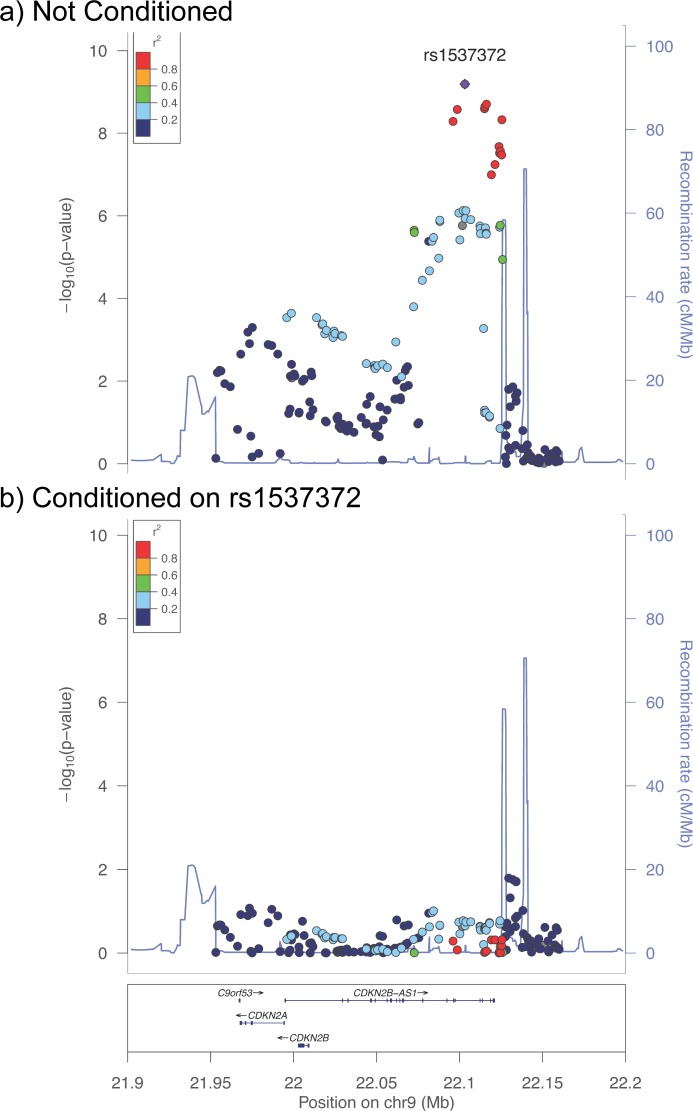
Conditional Analysis of the 9p21 Region.“Locus Zoom” plots [29] of the 9p21 region demonstrating conditional analysis of the top SNP rs1537372 using logistic regression adjusted for age, gender, and the eigenvalues from principal components 1 and 2. Linkage disequilibrium of SNPs with rs1537372 is shown by the color of the points and is based on data from the Asian subjects in the Thousand Genomes Project. a) Association of SNP with coronary disease; b) Association of SNP with coronary disease conditioned on rs1537372 (rs1537372 added as an additional covariate).